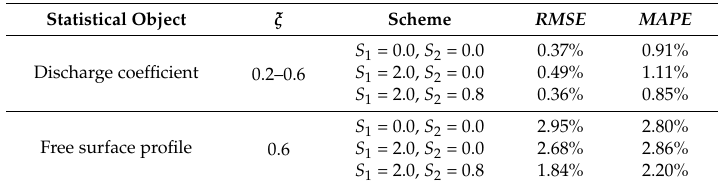
Table 4. RMSE and MAPE for discharge coefficients and flow surface